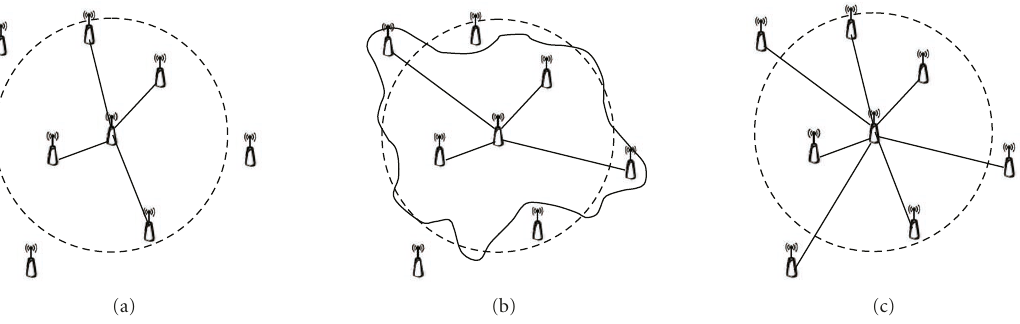
Figure 1: Node’s neighborhood with di ff erent radio link models: (a) perfect unit disk, (b) switched links with shadowing, (c) unreliable links accounting for transmission errors. With this latter model, all nodes are neighbors with a given successful transmission probability, visualized by the lines’ thickness.